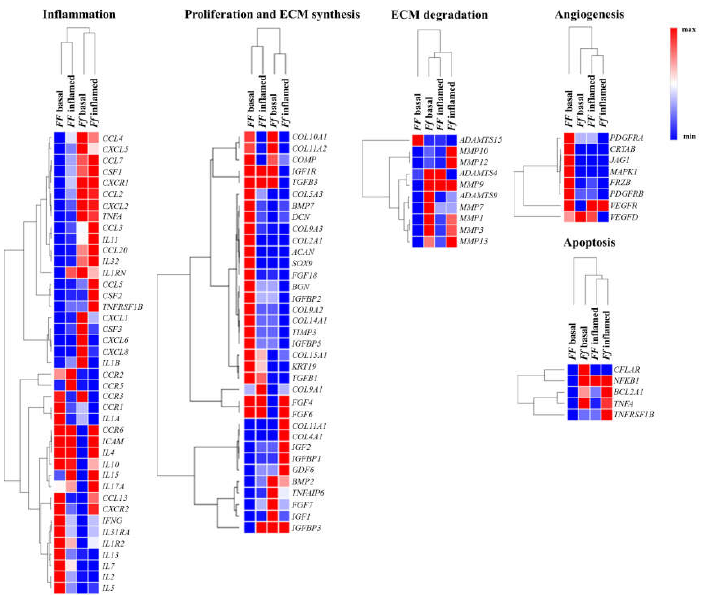
Figure 7. Heat maps shows relevant group of genes differently modulated by vitamin D depending on FokI genotype in basal and inflamed conditions. Heat maps obtained by Morpheus, https://software.broadinstitute.org/morpheus (Date of access 6 April 2021). Vitamin D modulated some genes involved in extracellular matrix (ECM)